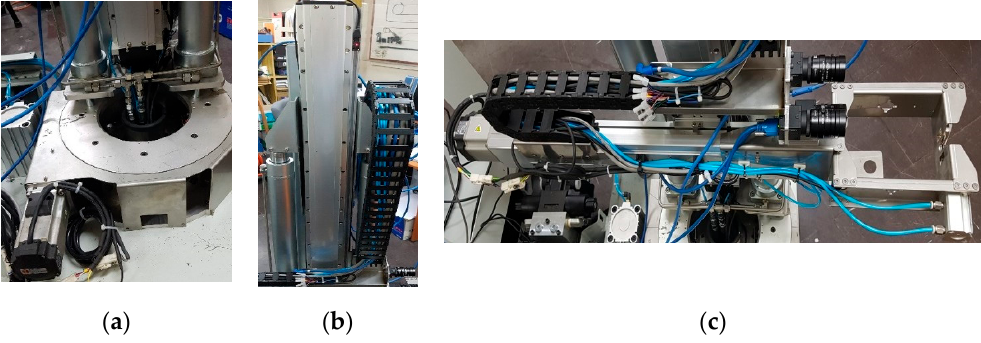
Figure 2. Manipulator: (a) rotation axis; (b) vertical axis; (c) horizontal z axis.